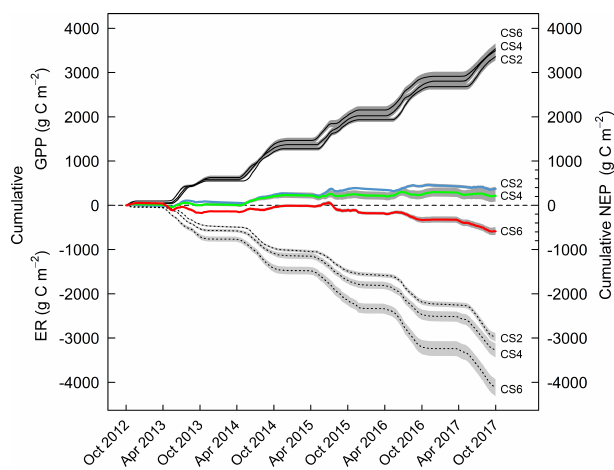
Figure 3. Cumulative trajectory of gross primary productivity (GPP, solid lines), ecosystem respiration (ER, dashed lines) and net ecosystem productivity (NEP, colored lines) at three climate sce- nario sites from October 2012 to September 2017. Displayed are means ± 1SE (shaded grey) of the control treatment that received neither irrigation nor additional